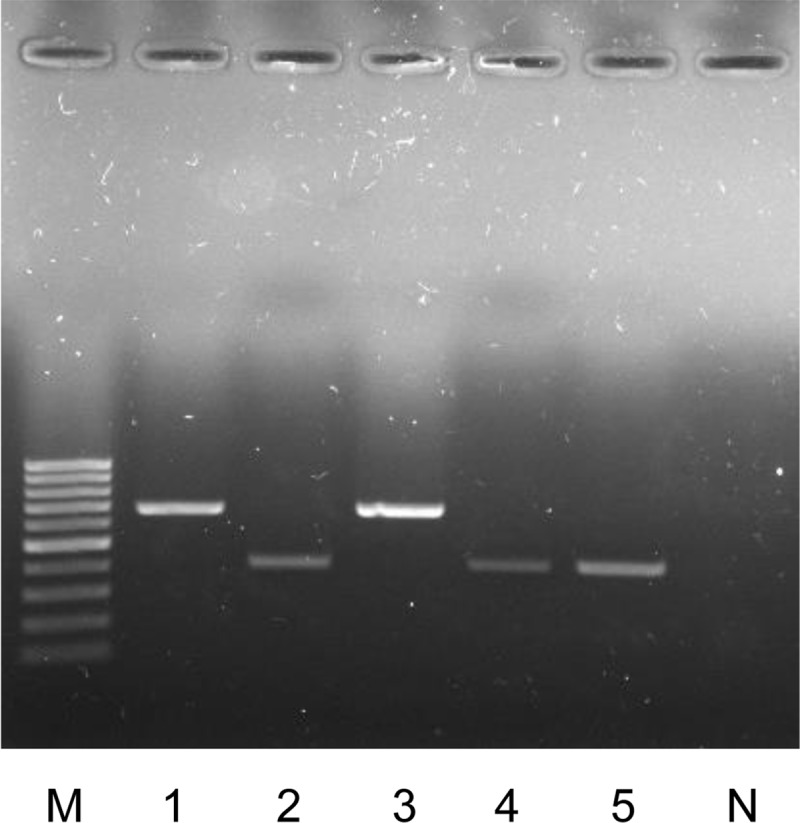
Identification of two Rec-mas-H strains at the subspecies level by PCR targeting the erm(41) gene.M, 100-bp DNA ladder; Lane 1, M. abscessus subsp. abscessus CIP 104536T; Lane 2, M. abscessus subsp. massiliense CIP 108297T; Lane 3, M. abscessus subsp. bolletii CIP 108541T; Lane 4, Asan 55814; Lane 5, Asan 55262; N, negative control.